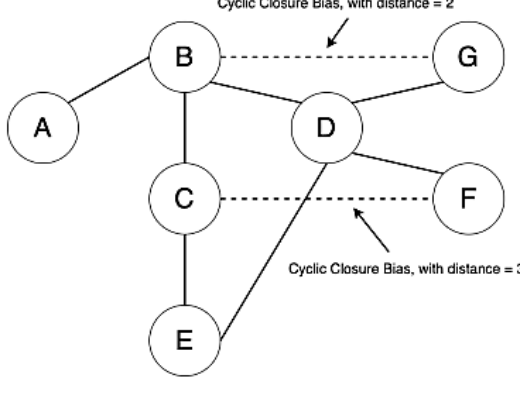
Figure 3. Cyclic Closure Bias